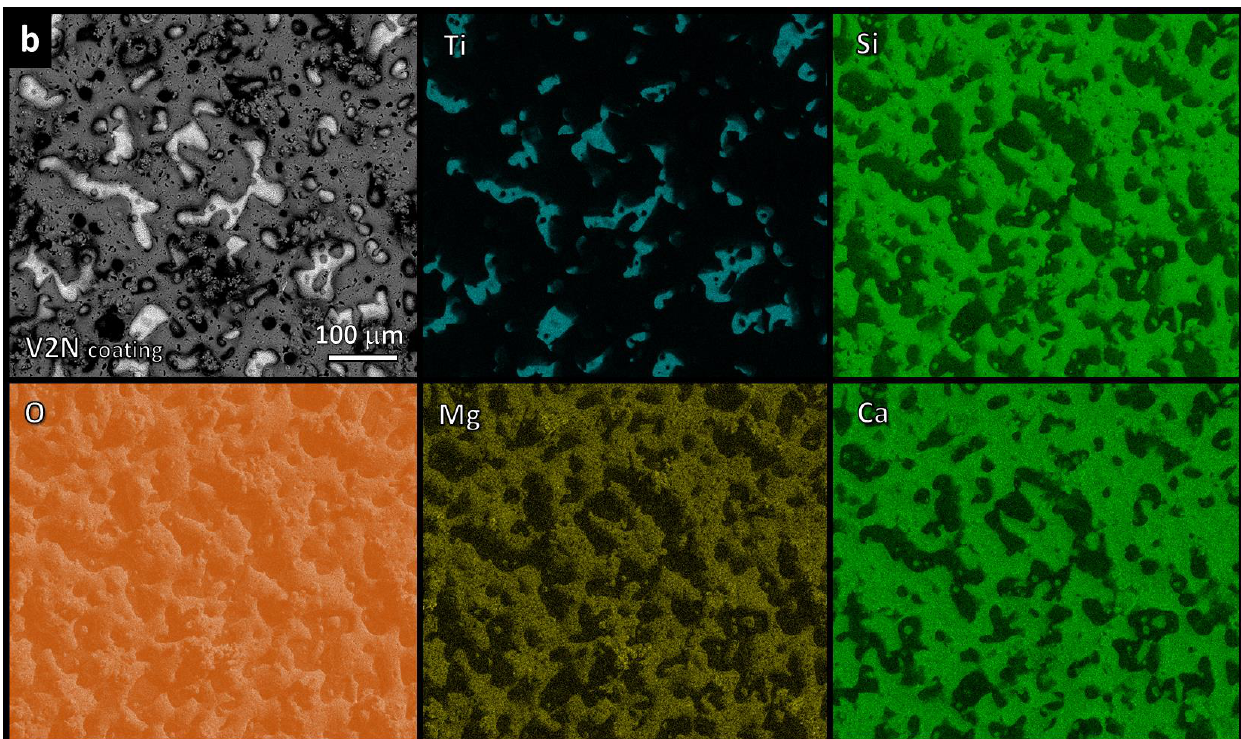
Figure 7. EDS maps of glass – ceramic coatings fired in argon: ( a ) V1N (1.5 s) ( b ) V2N (1.5 s).